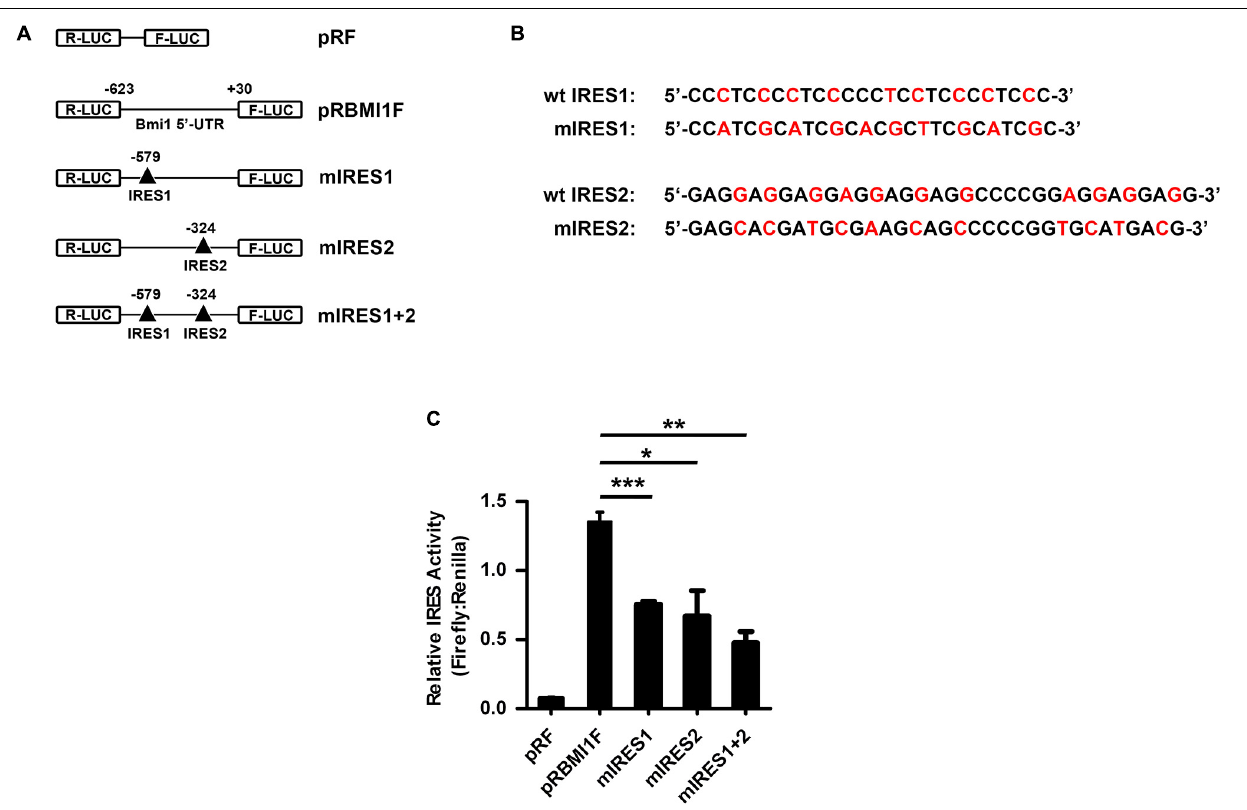
FIGURE 5 | IRES1 and IRES2 mediate the translational activity of 5 (cid:48) -UTR in CNE2 cells. (A) Schematic of the potential IRES1 and IRES2 elements in the Bmi1 5 (cid:48) -UTR. The mutation is labeled as “ (cid:49) .” The IRES1 and IRES2 or double mutations of Bmi1 5 (cid:48) -UTR were subcloned in pRF vector and were designated as mut-IRES1, mut-IRES2, and mut-IRES1 + 2. (B) The IRES1 and IRES2 mutant base was labeled as red. (C) The translational activity analysis of the IRES 1 and IRES2 mutant 5 (cid:48) -UTR of Bmi1 in CNE2 cells. The plasmids containing the IRES1 and IRES2 mutant 5 (cid:48) -UTR were transfected into CNE2 cells. Luciferase activity was detected at 24 h post-transfection. A representative result of three independent experiments is shown ( n = 3). The graphs show the mean ± SEM. * P < 0.05, ** P < 0.01, and *** P < 0.001; Student’s t -test.